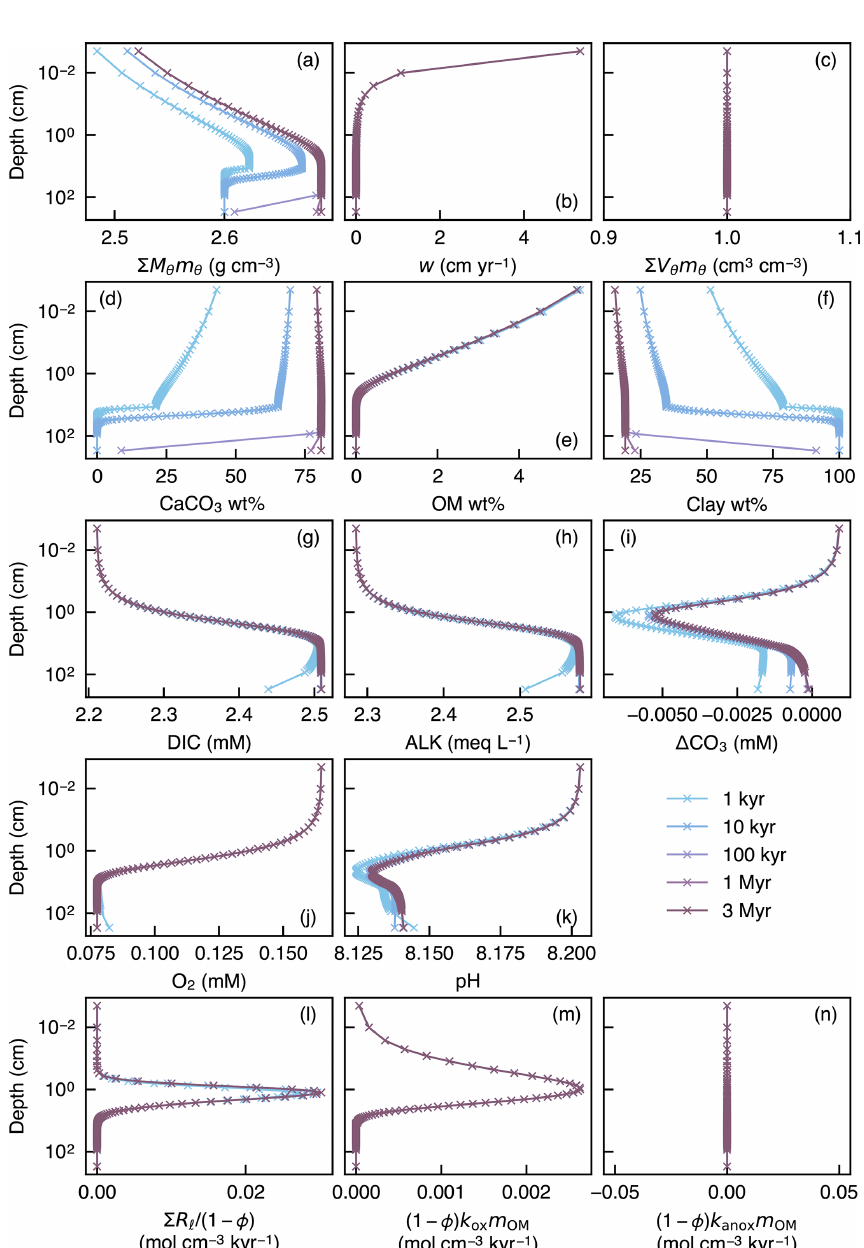
Figure 6. Depth profiles of the density (a) and volume fraction (c) of solid sediment, burial velocity (b) , weight fractions of bulk CaCO 3 (d) , organic matter (e) and nonreactive detrital materials (f) in solid sediment, porewater concentrations of total dissolved CO 2 species (g) , carbonate alkalinity (h) and oxygen (j) , deviation of porewater carbonate concentration from that in equilibrium with CaCO 3 (i) , porewater pH (k) , dissolution rate of CaCO 3 (l) , and decomposition rate of organic matter in the oxic (m) and anoxic (n) zone of sediment, as a function of time. The boundary conditions of the model are parameterized with the default parameter values (Table 1). The calculations assume four classes of CaCO 3 particles and Fickian mixing for bioturbation. Illustrated is the temporal evolution of the depth profiles from initial conditions (Sect. 2.3) to a steady